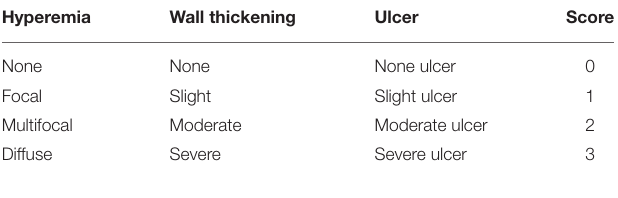
TABLE 2 | The criteria of colonic macroscopic score.